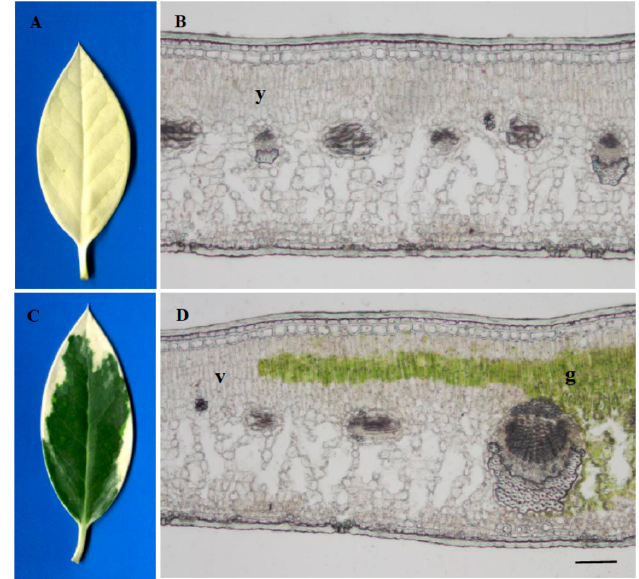
Figure 1. Comparative leaf structures between the full-yellow juvenile leaf ( A ) and mature variegated leaf ( C ) of I. altaclerensis ‘Belgica Aurea’. ( B , D ) were transverse sections of full-yellow and variegated leaf, respectively. Scale bar = 100 μ m. y: full-yellow juvenile leaf; v: yellow sectors of variegated leaf; g: green sectors of variegated leaf. Transmission electron microscope (TEM) observations showed that the chloroplasts were ellipsoidal shape. The chloroplasts in the mesophyll cell from green parts (g) of the variegated leaves were well developed with complete grana stacks and well-arranged stroma lamellae (Figure 2A). In contrast, only few thylakoid lamellae were found in the chloroplasts of yellow leaves (Figure 2B) and yellow parts of the variegated leaves (Figure 2C), and no complete grana stacks were formed.